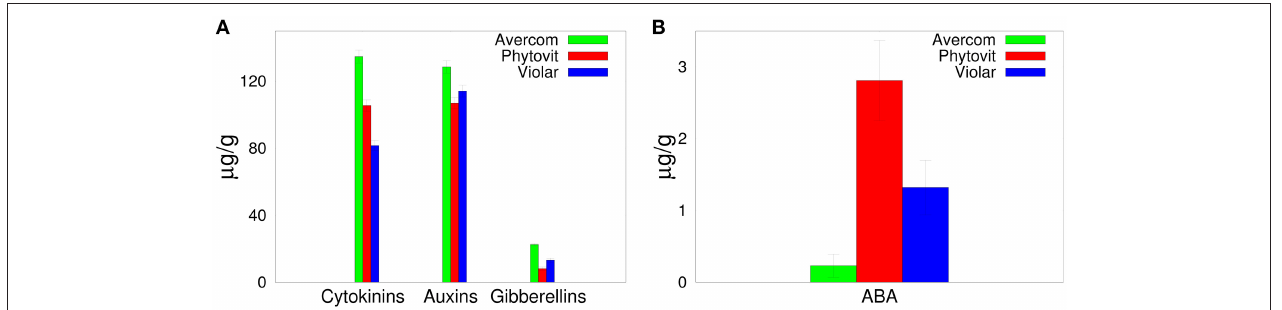
FIGURE 1 | Plant hormone composition of